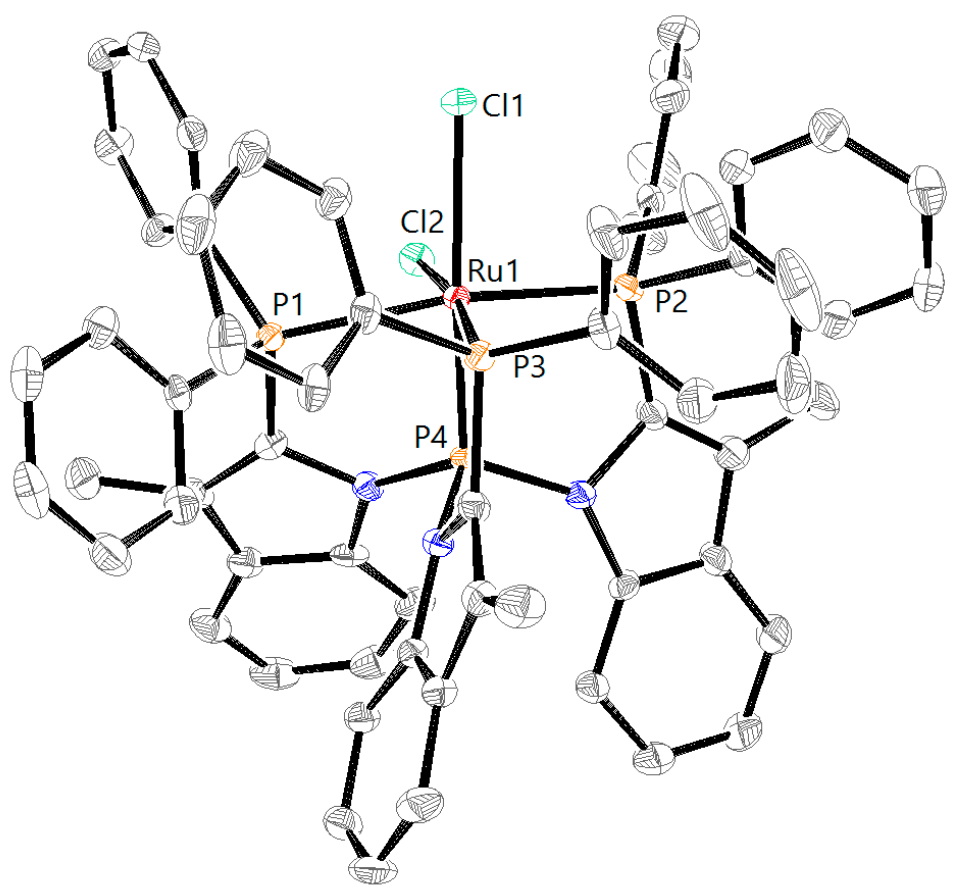
Figure 7. ORTEP drawing of RuCl 2 L2 H (CCDC 1574140) showing a side view of one of the two rotamers. Thermal ellipsoids are set at 50% probability. Solvent molecules and hydrogen atoms have been omitted for clarity.